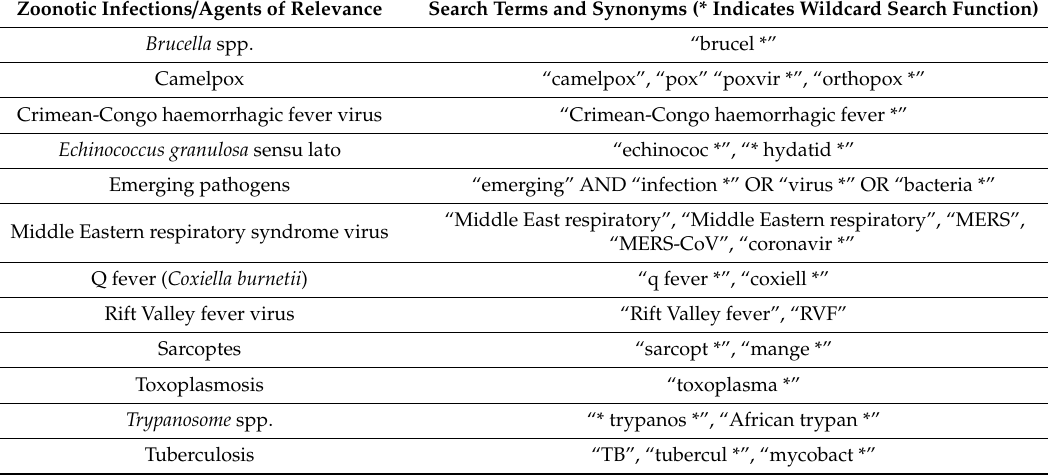
Table 1. Search terms and synonyms used to construct searches relating to zoonotic pathogens of camels in Kenya.